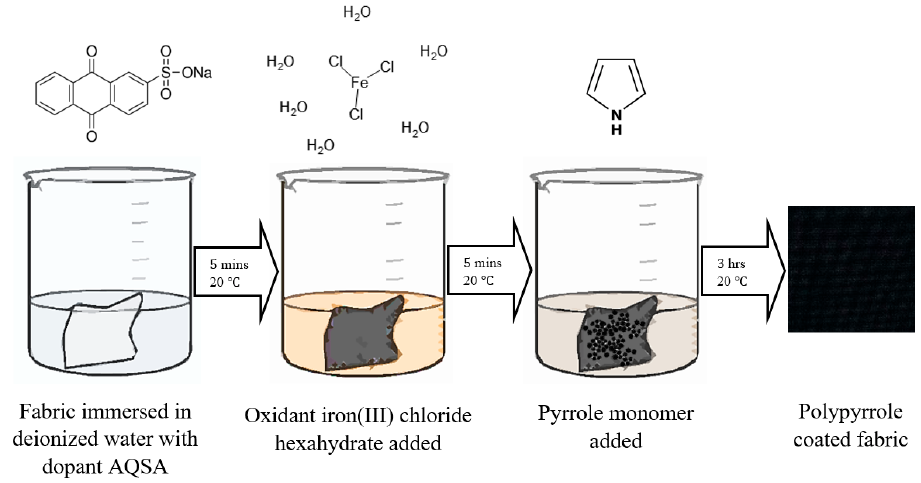
Figure 1. Schematic representation of preparation of the conductive fabric.